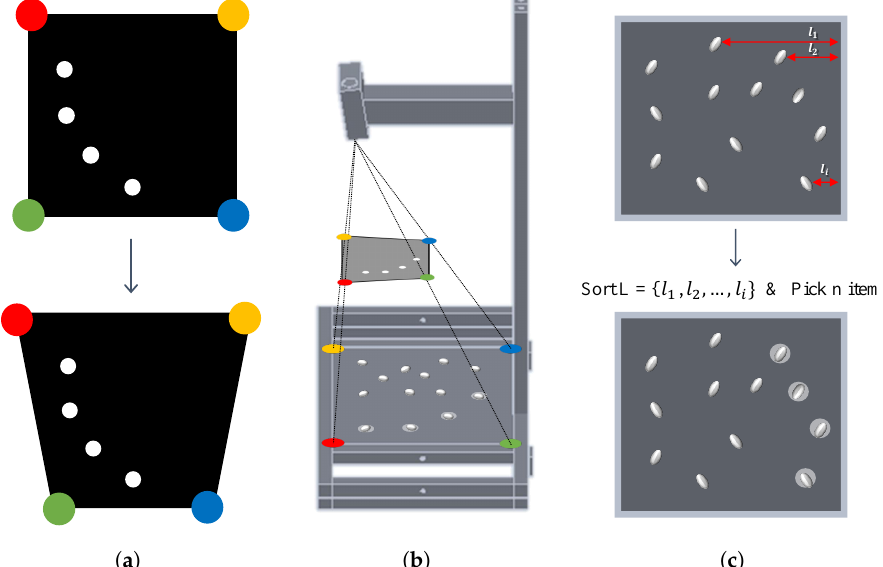
Figure 7. Beam projector output transformation. ( a ) Perspective transformation. ( b ) Transformed output from beam projector. ( c ) Process of selecting excessive